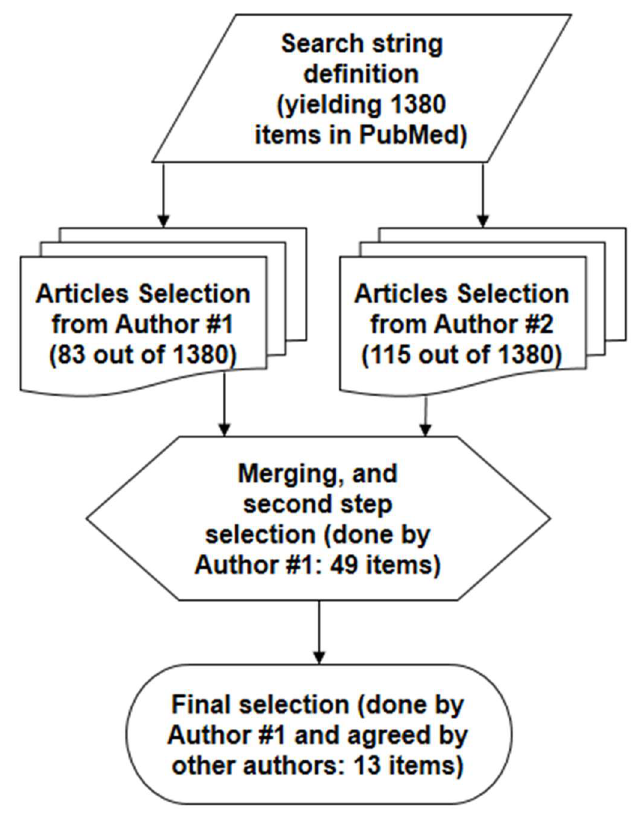
Figure 1. Flow diagram of the primary scientific literature search.